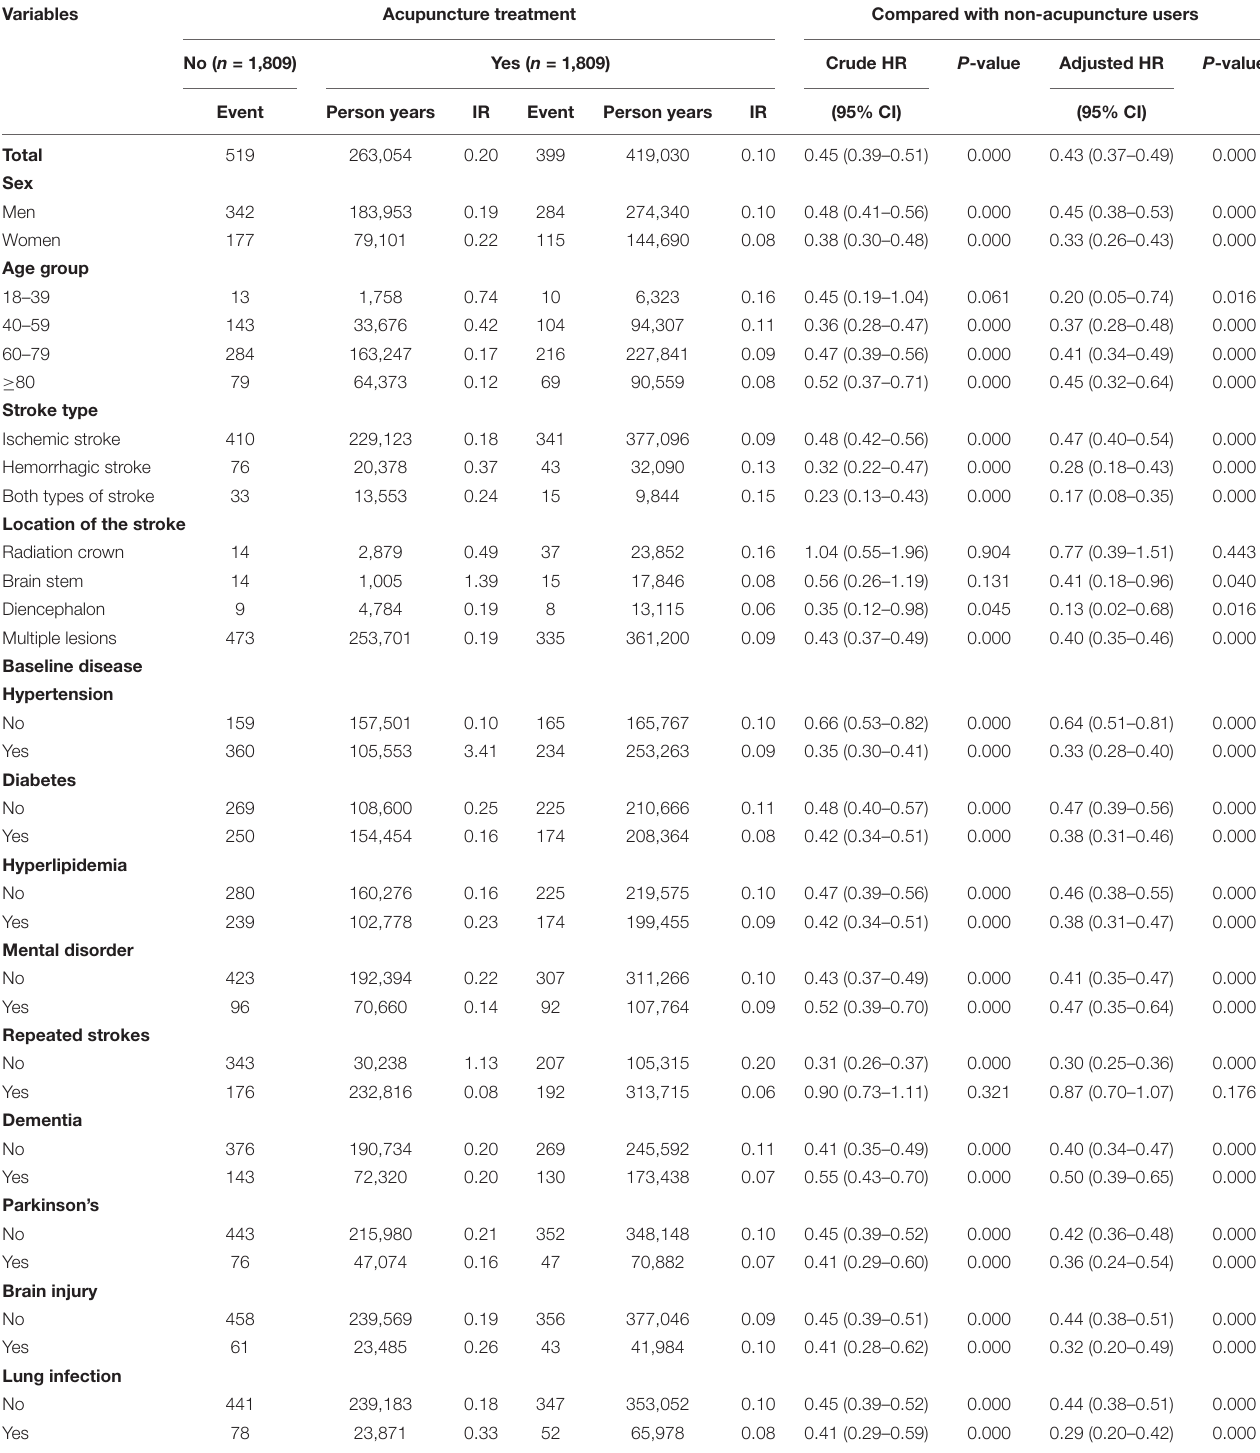
TABLE 3 | The respective hazard ratios and Incidence rates of the acupuncture and non-acupuncture cohorts before and after adjustment for gender, age, stroke type, stroke site, and baseline complications.